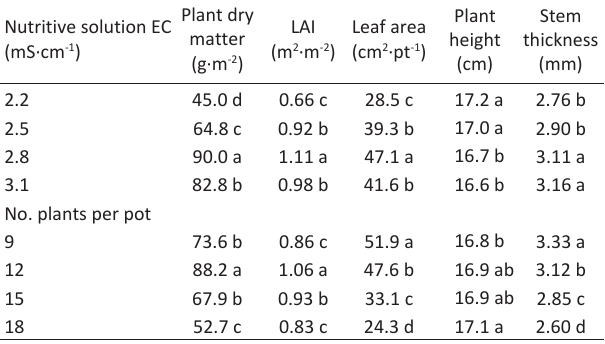
Table 3 - Basil growth and biometrical